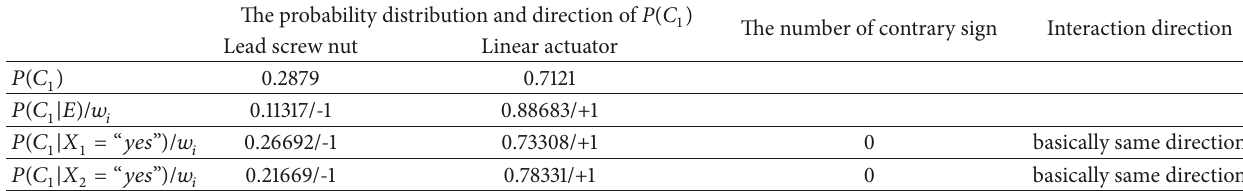
Table 10: The direction from each evidence to the inference